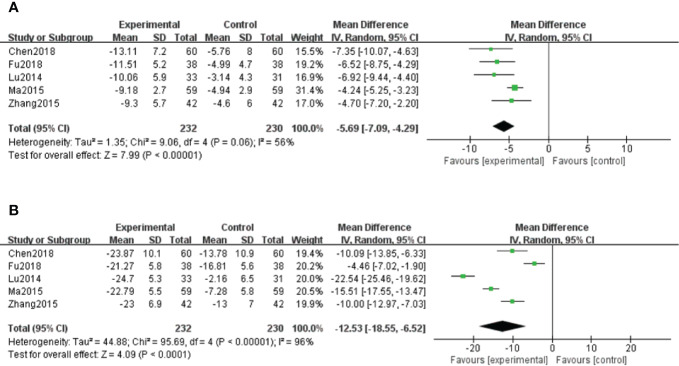
Forest plot for hypersensitive C-reactive protein (hs-CRP) between the treatment group and control group (A). Forest plot for interleukin-6 (IL-6) between the treatment group and control group (B).